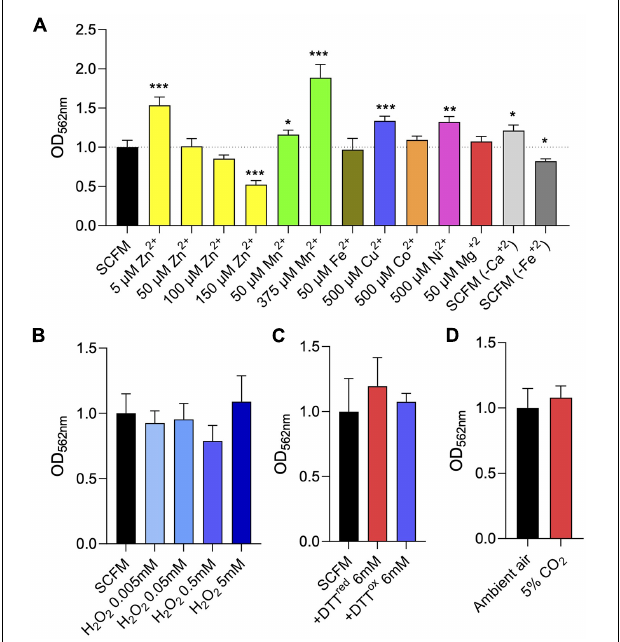
FIGURE 7 | Effect of divalent cation and other environmental cues on MABSC biofilm formation in synthetic CF medium. (A) Crystal violet quantification of Mabs NJH12 biofilms after 5 days of incubation in standard SCFM medium, SCFM supplemented with various metal ions, or SCFM devoid of CaCl 2 or FeSO 4 . The growth curves of Mabs NJH12 in the corresponding culture media are presented in Supplementary Figure 6 . (B) Biofilm formation of Mabs NJH12 in SCFM in the presence of increasing concentrations of H 2 O 2 . Mabs NJH12 biofilm cultures were exposed to 0.005–5 mM H 2 O 2 from the time of inoculation and biofilm formation was measured by crystal violet staining after 5 days (Geier et al., 2008). (C) Impact of thiol reductive stress on Mabs NJH12 biofilm formation. Mabs NJH12 biofilm cultures were added 6 mM reduced DTT (GoldBio) or 6 mM oxidized DTT (Sigma) at the time of inoculation and incubated for 24 h prior to crystal violet staining. (D) Biofilm formation of Mabs NJH12 in SCFM under a 5% CO 2 atmosphere compared to ambient air. Asterisks denote statistically significant differences between enzyme treatment and control groups (standard SCFM medium under ambient air) pursuant to the Student’s t -test (* p < 0.05, ** p < 0.005, and *** p < 0.0005). Crystal violet values are expressed relative to untreated biofilm values (grown under ambient air) arbitrarily set to